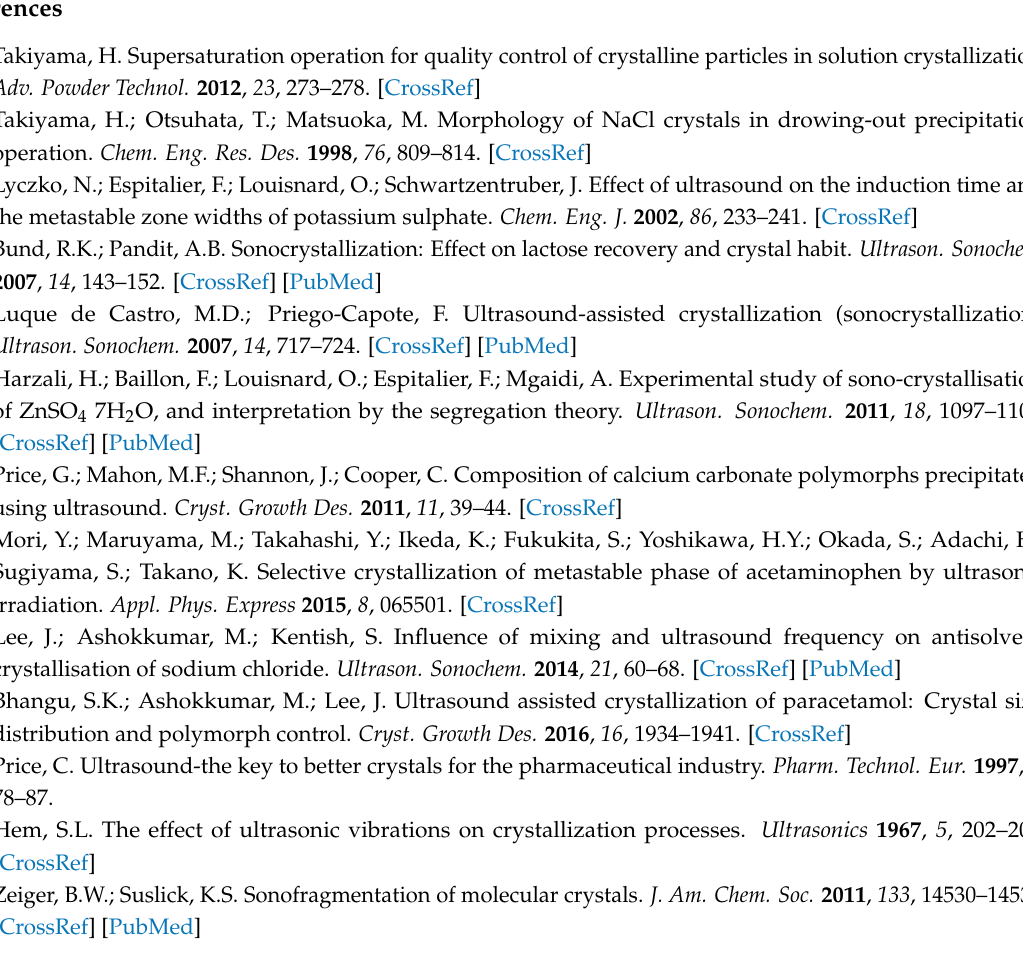
Figure S1: An example of turbidity as a function of time data obtained and how induction time was determined. (a) a typical data and (b) interference from degassed bubbles when supersaturation is first established, Table S1: Induction time for different supersaturation ratios in the absence of ultrasound. A stirring speed of 100 rpm was applied, Table S2: Induction time for different supersaturation ratios in the presence of 98 kHz and 2 W sonication. A stirring speed of 100 rpm was applied, Table S3: Induction time for different supersaturation ratios in the presence of 98 kHz and 5 W sonication. A stirring speed of 100 rpm was applied, Table S4: Induction time for different supersaturation ratios in the presence of 98 kHz and 15 W sonication. A stirring speed of 100 rpm was applied, Table S5: Induction time for different supersaturation ratios in the presence of 22 kHz and 2 W sonication. A stirring speed of 100 rpm was applied, Table S6: Induction time for different supersaturation ratios in the presence of 44 kHz and 2 W sonication. A stirring speed of 100 rpm was applied, Table S7: Induction time for different supersaturation ratios in the presence of 139 kHz and 2 W sonication. A stirring speed of 100 rpm was applied, Table S8: Induction time for different supersaturation ratios in the presence of 500 kHz and 2 W sonication. A stirring speed of 100 rpm was applied, Table S9: Parameters γ , ∆ WU and A for different ultrasound powers, determined by fitting Equation (6) to the data in Figure 6. It was assumed that the supersaturation ratio is unaffected by ultrasound. The pre-exponent A and γ obtained using Equation (3) for absence of ultrasound are also shown for